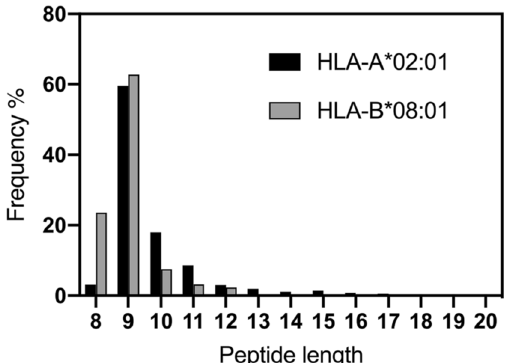
Figure 5. Length distribution of antigenic peptides that bind to HLA-B*08:01 and HLA-A*02:01. Data were extracted from the immune epitope database and analysis resource (www. iedb. org) 28 , 7231 total peptides for HLA-B*08:01 and 33,362 total peptides for HLA-A*02:01. Frequency distribution analysis was performed with Graphpad Prism